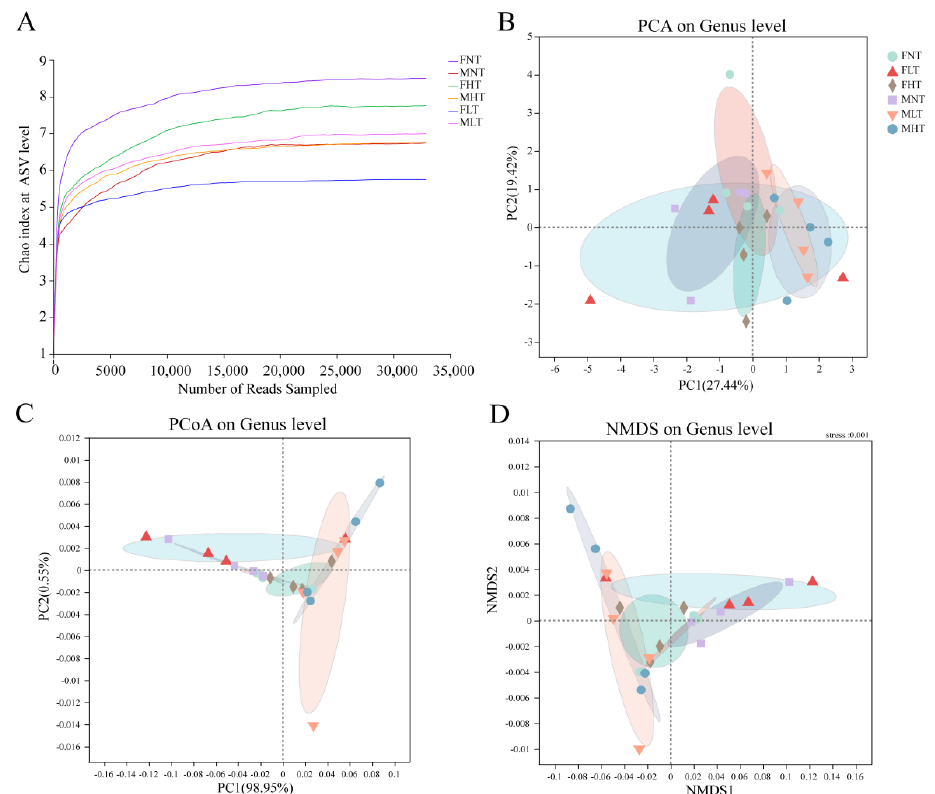
Figure 1. Rarefaction curves of α -diversity indices and β -diversity plots of bacterial communities in D . citri by temperature. ( A ) Chao I diversity index. Samples’ cluster analysis plot of the bacterial communities ( B – D ) of D . citri adults at different temperatures, at the genus level. ( B ) Principal components analysis (PCA). ( C ) Principal coordinates analysis (PCoA). ( D ) Non–metric multidimensional scaling (NMDS) analysis. The different color circles and triangles correspond to samples from D. citri adults. FNT and MNT: female and male under a normal temperature (26 ◦ C); FHT and MHT: female and male under a high temperature (42 ◦ C); FLT and MLT: female and male under a low temperature (15 ◦ C). Every group used four biological replicates of D. citri .